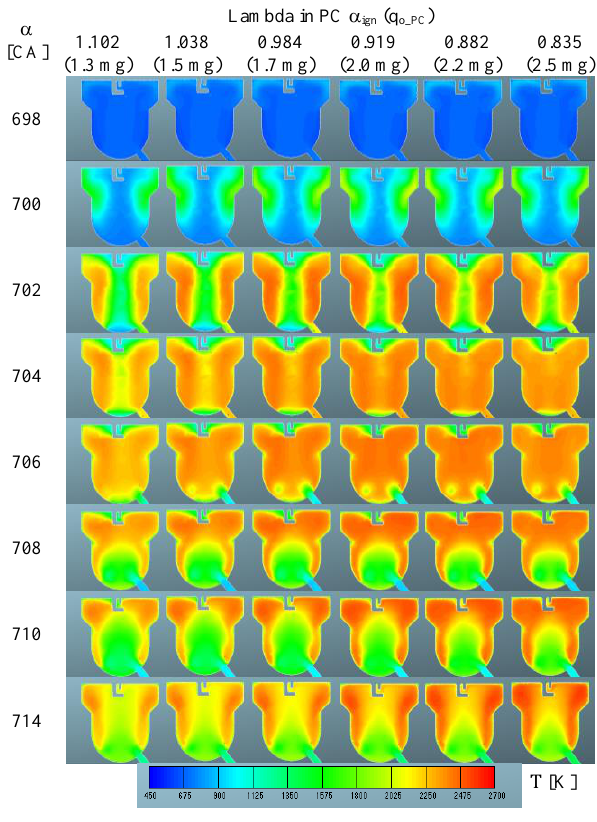
Fig. 12. Temperature changes in the prechamber at different fuel dose values q